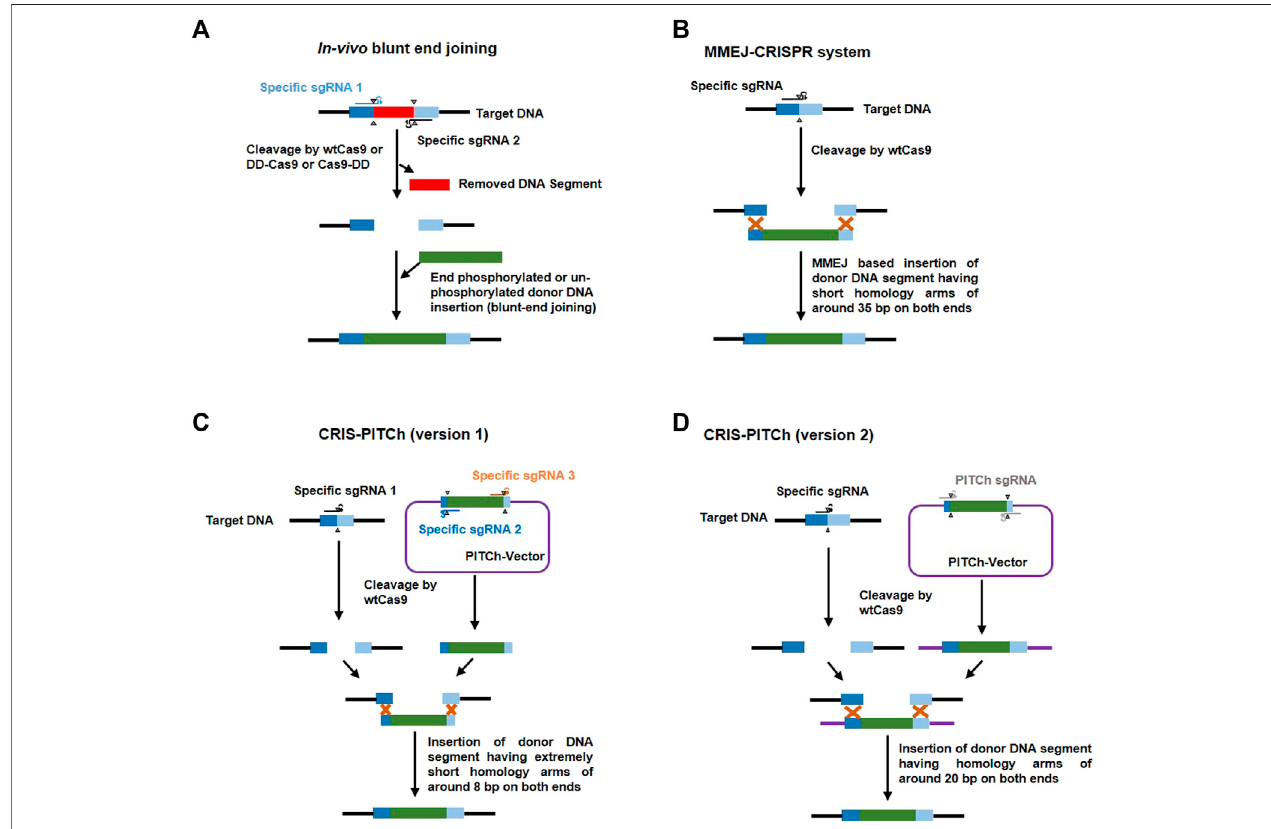
FIGURE 5 | Representative methods in donor-based host genome editing. (A) In vivo blunt-end joining involves using two target speci fi c sgRNAs (blue and black) tocleavetargetDNA[releasingaDNAsegment(red)]witheitherwildtypecas9(wtCas9)orCas9 attachedtotheproteindestabilizationdomain(DD)likeFKBP12-L106P which destabilizes Cas9 in the absence of a stabilizing agent, such as Shield-1 (Clontech); it leads to precise knock-in of donor DNA (green) via non-homologous end joining (NHEJ). (B) The MMEJ-CRISPR system involves cleavage of target DNA using one speci fi c sgRNA (black) and wtCas9; and integration of a donor DNA fragment (with around 35 bp homologous arms at both ends (dark and light blue) at the cut site through the process of microhomology-mediated end joining (MMEJ) during the M-early S phases of the cell cycle. (C) CRIS-PITCh version 1 involves three speci fi c sgRNAs [one to cleave target DNA (black) and the other two (yellow and brown) to cleave the DNA sequence fl anking outside the homologous sequence (8 bp) in the donor vector (PITCh-vector) which releases a donor DNA segment with homologous arms (dark and light blue)] and wtCas9 to precisely integrate any gene of interest without end trimming by proximal MMEJ. (D) CRIS-PITCh version 2 also involves three sgRNAs [one speci fi csgRNA (black) forhost target genomecleavage and two generalPITCh sgRNAs (grey)to cleave theDNA sequence fl anking outside the homologous sequence (20 bp) in the donor vector (PITCh-vector) which releases a donor DNA segment with homologous arms (dark blue and light blue)] and wtCas9 to precisely integrate any gene of interest with end trimming by distal